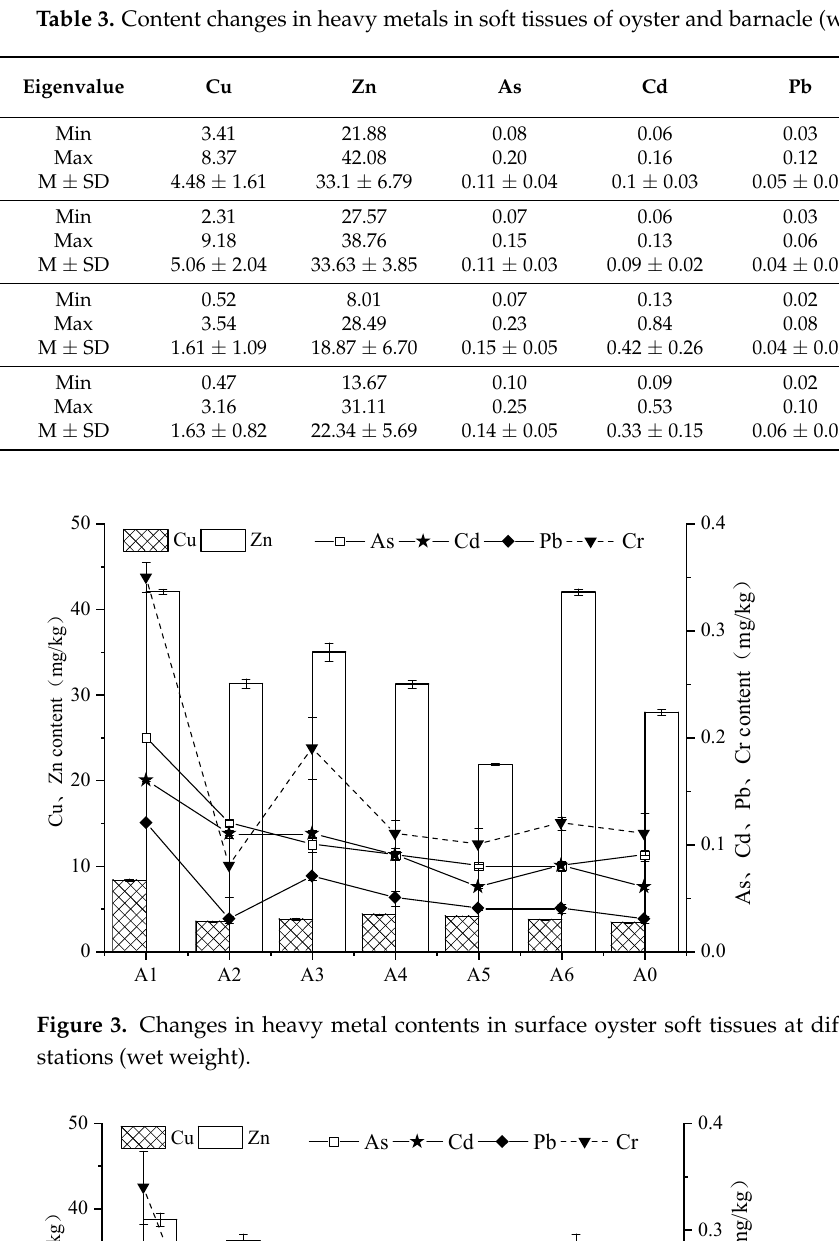
Figure 5. Changes in heavy metal content in soft tissue of surface barnacle at different monitoring stations (wet weight).